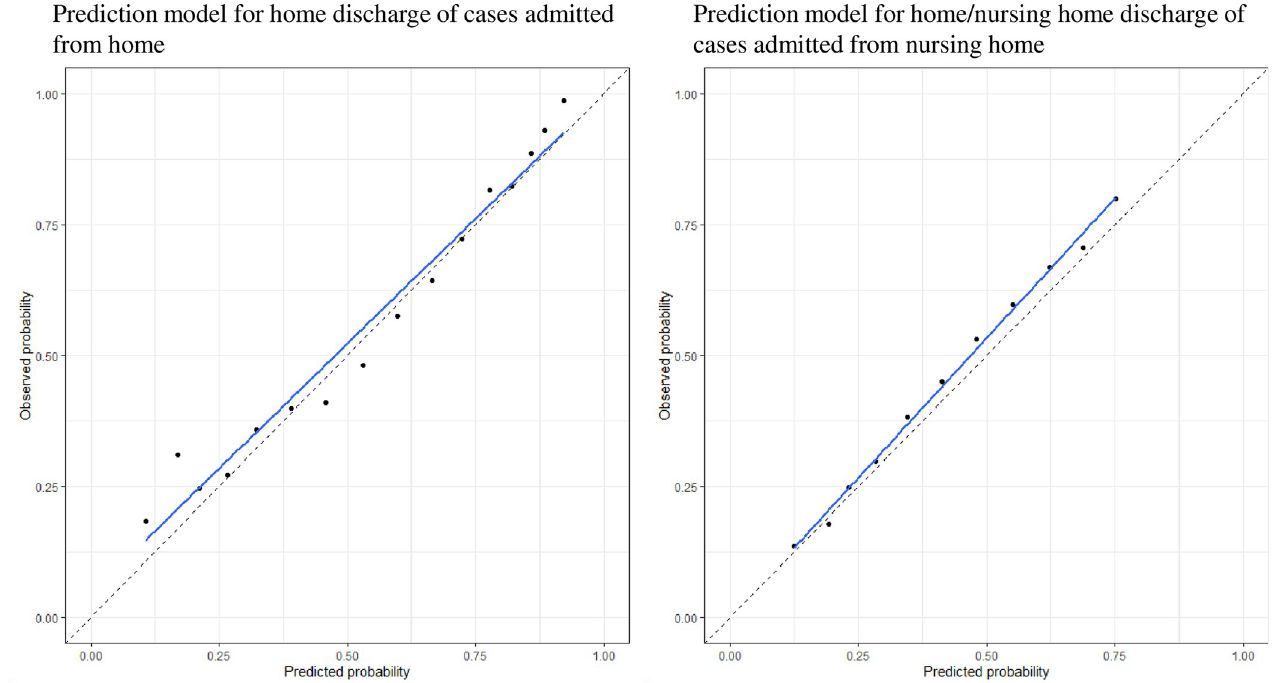
Fig 4. Results of validation using calibration plots of probability scores of the two models. The dots represent each probability score. The blue lines are the regression lines through the dots of the probability scores.